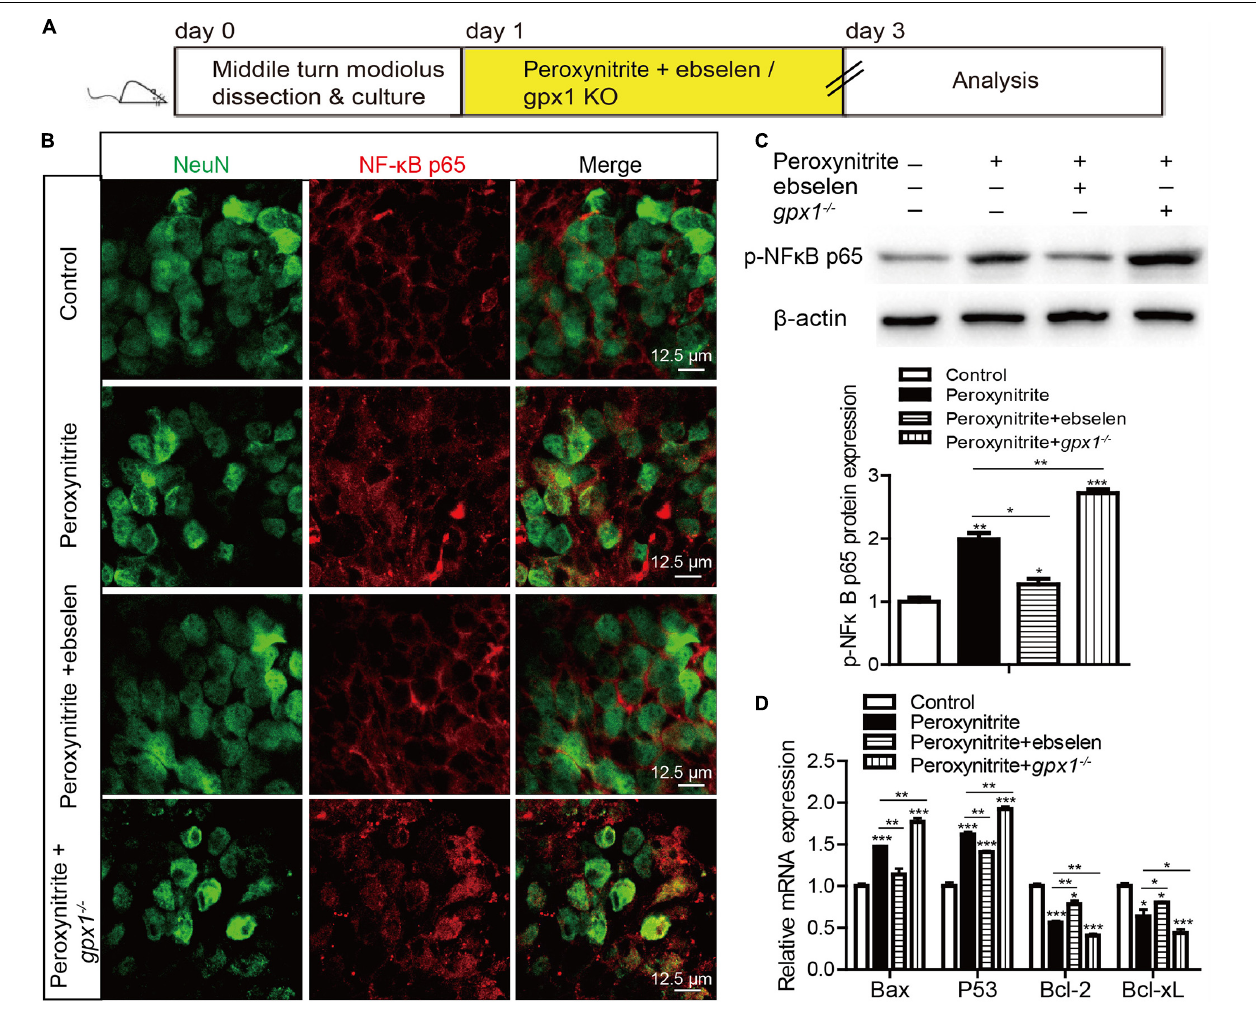
FIGURE 8 | The activated nuclear factor-kappa B (NF- κ B) pathway is inhibited by GPX1 in SGNs after peroxynitrite damage. (A) The cultured SGNs from P3 WT mice were incubated with 100 µ M peroxynitrite for 48 h with or without the pretreatment of 30 µ M ebselen for 1 h, or the SGNs from gpx1 − / − mice were exposed to 100 µ M peroxynitrite for 48 h. (B) The anti-NeuN antibody was used to label the nucleus of SGN, and the immunostaining results showed that the fluorescence of NF- κ B p65 was mainly detected in the cytoplasm of SGNs in the control group. Peroxynitrite induced obvious nuclear distribution of NF- κ B p65 in SGNs and pretreatment with ebselen significantly reduced it, whereas the lack of GPX1 intensified the nuclear fluorescence of NF- κ B p65 in SGNs of the peroxynitrite + gpx1 − / − group. Scale bar = 12.5 µ m. (C) Western blot results verified that the expression of the p-NF-kB p65 protein was upregulated in peroxynitrite-exposed SGNs compared with the untreated controls, and the pretreatment with ebselen significantly reduced it while the lack of GPX1 increased it. (D) Real-time PCR (RT-PCR) results revealed that peroxynitrite treatment caused significant increases in the microRNA (mRNA) expression of proapoptotic genes Bax and P53 , and decreased the expression of antiapoptotic genes Bcl2 , Bcl-xL compared with controls. The lower mRNA expression levels of Bax and P53 and the higher expression levels of Bcl2 and Bcl-xL were found in the peroxynitrite + ebselen group compared with the peroxynitrite-only group, while the lack of GPX1 in SGNs from gpx1 − / − mice led to an opposite pattern. * p < 0.05, ** p < 0.01, and *** p < 0.001, n = 3 for each